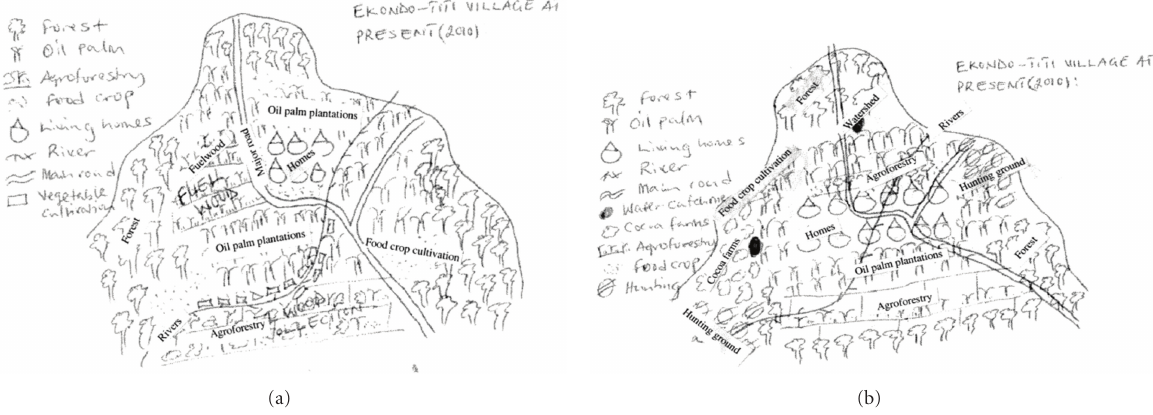
Figure 2: (a) Participatory resource maps of the present landscape drawn by women of Ekondo-Titi village showing the arrangement of the various resources in the area. (b) Participatory resource maps of the present landscape drawn by men of Ekondo-Titi village showing the arrangement of the various resources in the area.